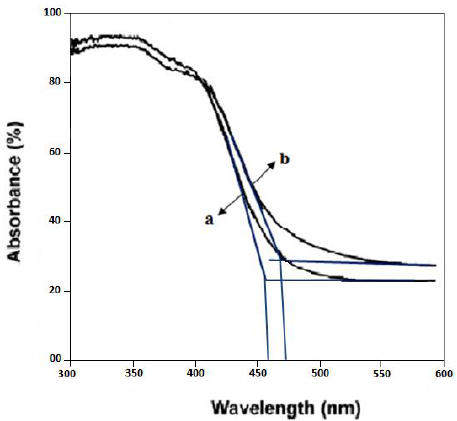
Fig.8. UV-vis diffuse reflectance spectra of (a) n-CeO